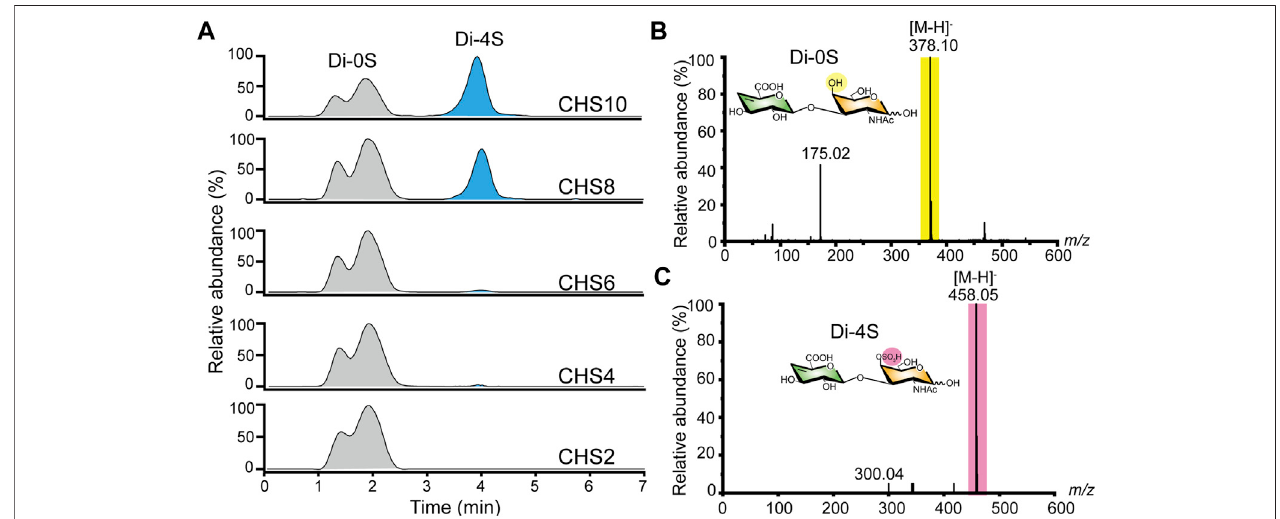
FIGURE 5 | Characterization of chondroitin sulfate A oligosaccharides via UPLC-MS. (A) The ion chromatogram of Di-4S was determined by UPLC-MS. (B) MS spectra of chondroitin disaccharide (Di-0S) (C) MS spectra of chondroitin sulfate A disaccharide (Di-4S). Di-0S, chondroitin disaccharide; Di-4S, chondroitin sulfate A disaccharide; CHS2, chondroitin disaccharide sulfate derivative; CHS4, chondroitin tetrasaccharide sulfate derivative; CHS6, chondroitin hexasaccharide sulfate derivative; CHS8, chondroitin octasaccharide sulfate derivative; CHS10, chondroitin decasaccharide sulfate derivative.